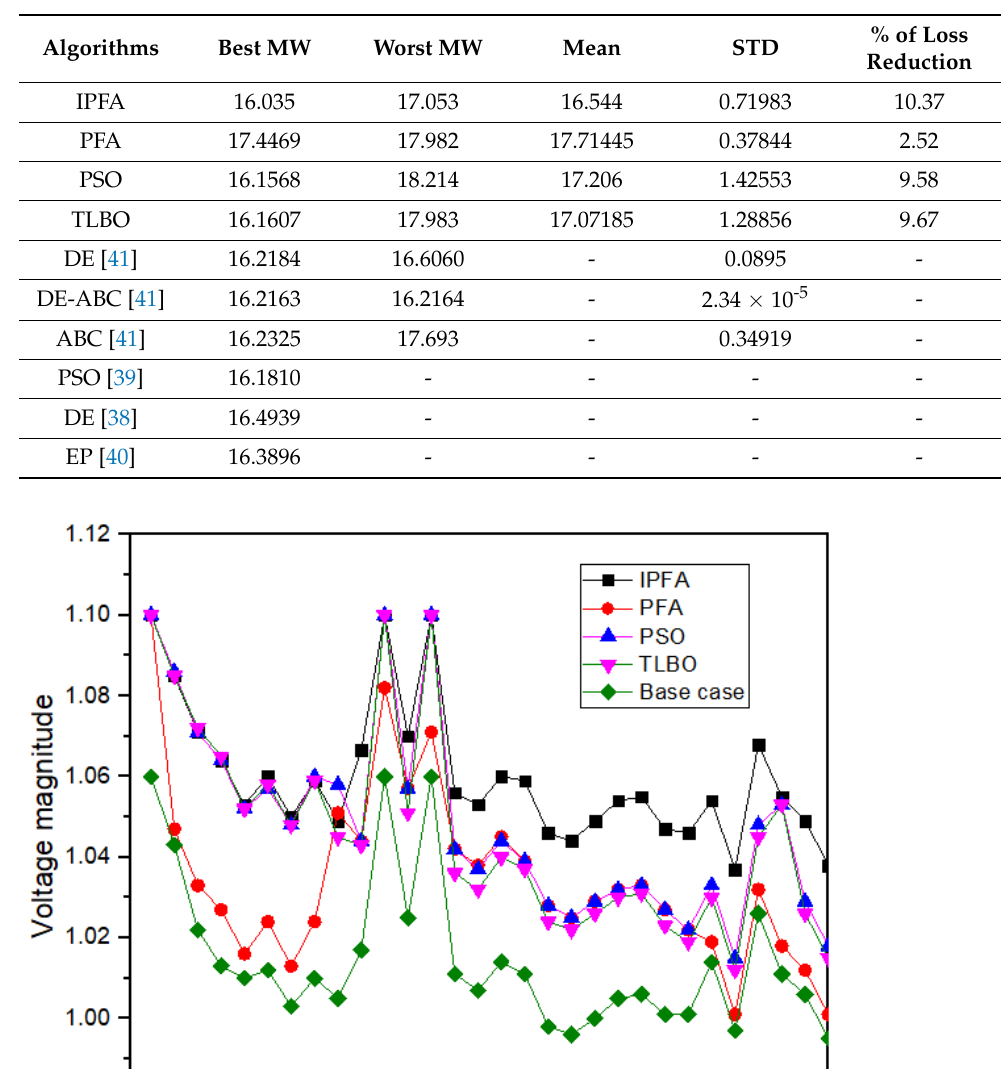
Table 4. Comparison of IPFA with other algorithms.